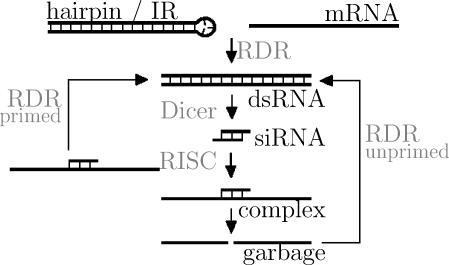
The Standard Pathway of RNA SilencingThe figure is based upon Figure 1 in Hutvágner et al. [48].